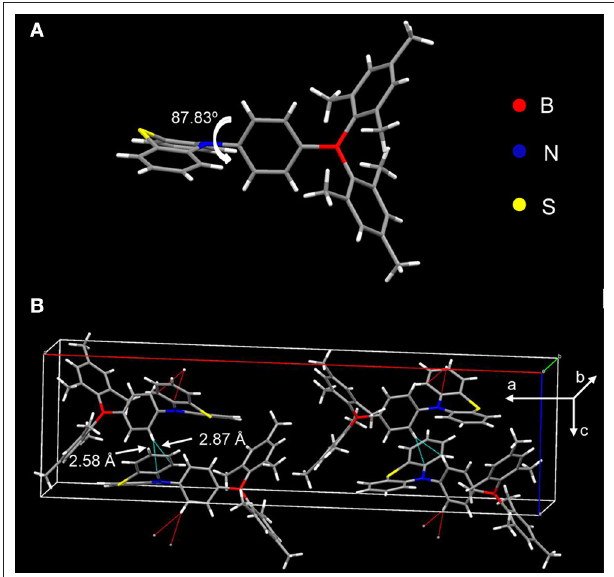
FIGURE 3 | XRD of single crystal of PTZMes 2 B: (A) molecular conformation; (B) molecular packing in